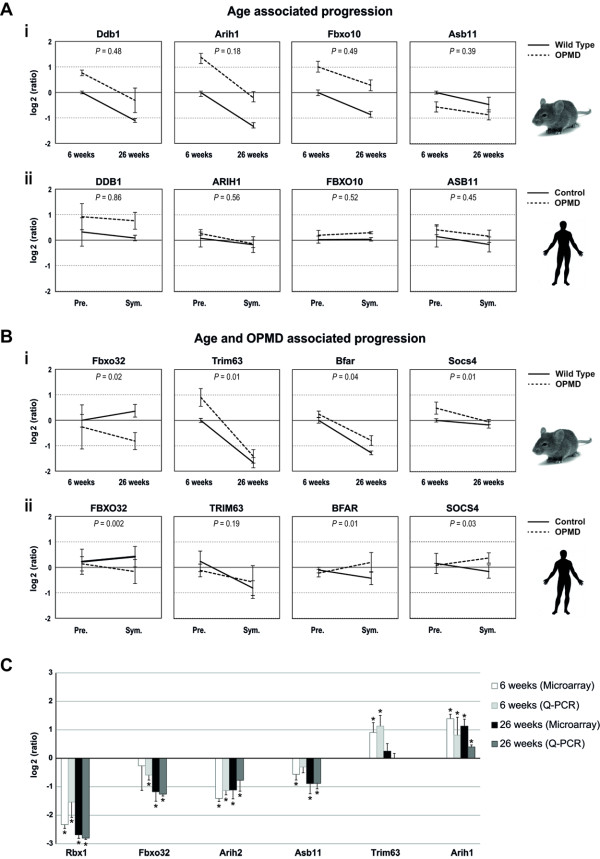
Progressive changes in UPS gene expression. Progression trends for selected genes in mice (i) and humans (ii). Expression values were normalized to six-week-old WT in mice, and to young healthy controls (19 years old on average) in humans. P-values demonstrate the significance of differences in expression trends between controls and OPMD samples. A) The age-associated progression trend is indicated by P-value >0.05. B) The genotype-specific progression trend is indicated by P-values <0.05. SD represents variations in mice (6 weeks N = 5 and 26 weeks N = 6) and in humans (expPABPN1 carriers N = 4 and controls N = 5). C) RT Q-PCR validation of selected deregulated genes in UPS was carried out on skeletal muscles of 6-week-old and 26-week-old mice. Histograms show the log2(ratio) of the measured expression values using microarray and Q-PCR. Significant changes with the P <0.05 are indicated by *.